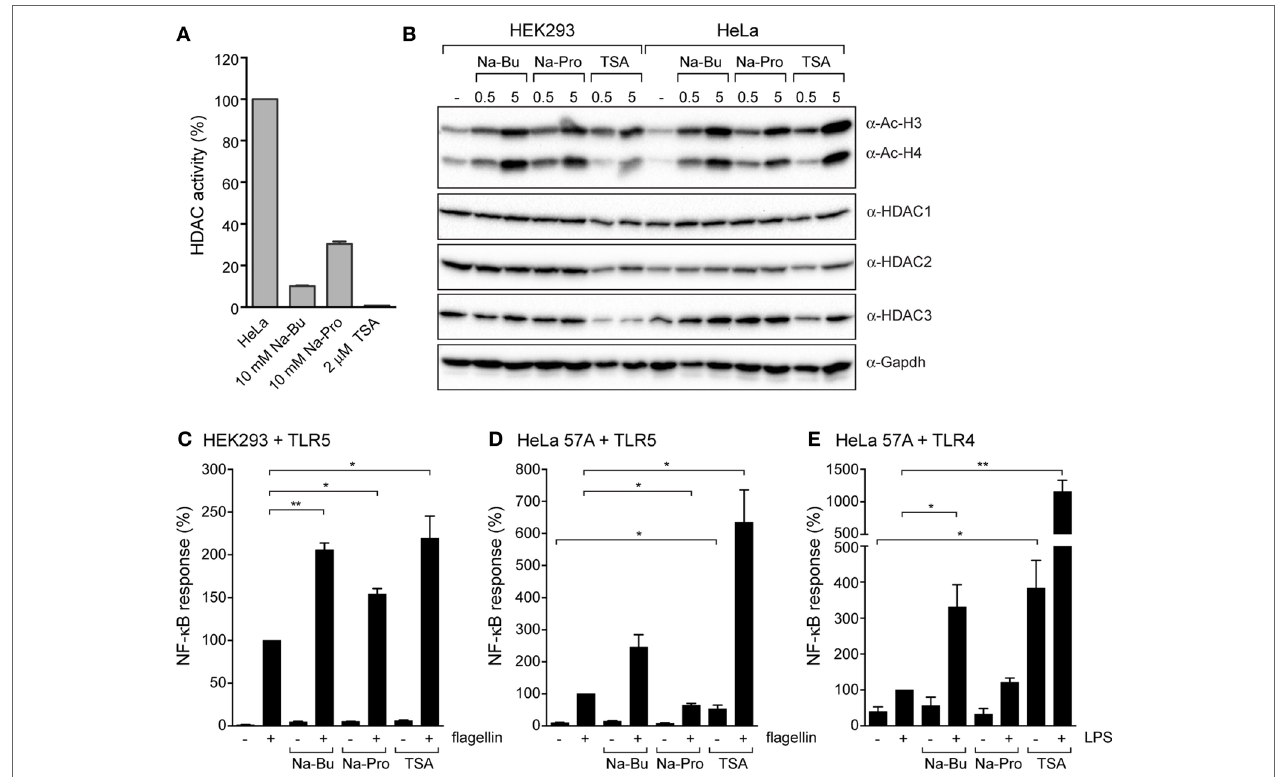
FigUre 4 | immunomodulatory effects of scFas are mimicked by the histone deacetylase inhibitor Tsa. (a) HDAC activity in HeLa lysates in the presence of 10 mM Na-butyrate, Na-propionate or 2 μ M TSA. (B) Immunoblots of HEK293 and HeLa 57A incubated with 10 mM Na-Bu, 10 mM Na-Pro or 2 μ M TSA for 30 min or 5 h analyzed with anti-acetyl-lysine antibody to visualize total histone acetylation and anti-HDAC1, HDAC2, HDAC3, and GAPDH antibodies. (c,D) . Immunomodulatory effects of SCFAs are mimics by histone deacetylase inhibitor TSA. TLR5-NF- κ B assays of HEK293 or HeLa 57A expressing TLR5 and an NF- κ B-luciferase reporter. Cells were incubated with 10 mM Na-Bu, 10 mM Na-Pro or 2 μ M TSA for 30 min followed by stimulation with S. enteriditis flagellin for 5 h. (e) TLR4-NF- κ B assays of HEK293 or HeLa 57A expressing TLR4 and an NF- κ B-luciferase reporter incubated with SCFA and LPS. Bars depict mean and SEM of three independent experiments. p < 0.05 (*), p < 0.01 (**), p < 0.005